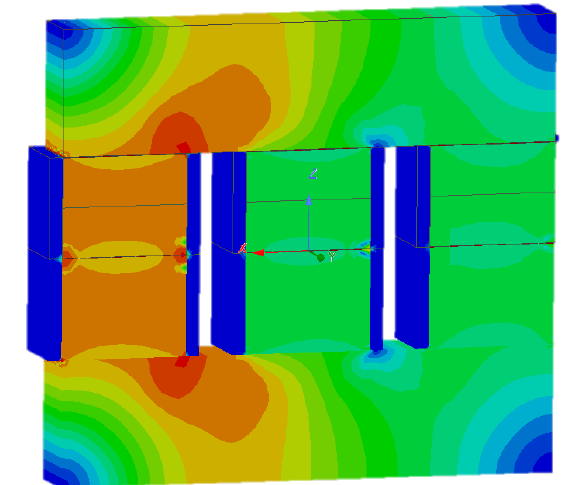
Figure 10. Magnetic-flux-density distribution in the choke designed for Case “ A ”